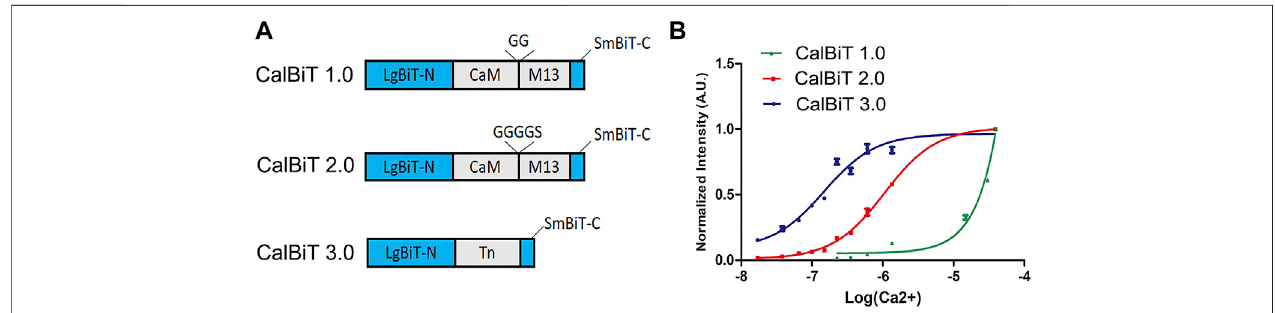
FIGURE 2 | Characteristics of CalBiTs in vitro . (A) The CaM-M13 or troponin C domain (TnC) was inserted between LgBit-N and SmBiT-C, two functional complementation fragments of NanoBiT (Dixon et al., 2016). Three versions of CalBiT were developed using different linkers and Ca ++ -binding domains. In CalBiT1.0, two Gly residues were used as linkers between CaM and M13 and GGGGS was used as a linker between CaM and M13 in CalBiT2.0, whereas TnC was the Ca ++ - binding domain inserted between LgBit-N and SmBiT-C in CalBiT3.0. (B) Comparison of [Ca ++ ] dependency in vitro for CalBiT1.0 (green line), CalBiT2.0 (red line), and CalBiT3.0 (blue line). The intensities of the three CalBiTs were measured by a QuantaMaster spectro fl uorimeter (not using fl uorescence excitation). The plotted values were normalized to the maximal signal intensity achieved at 39 mM Ca ++ . Values for the Hill coef fi cient and Kd of Cal fl ux VTN are shown in Table 2 , mean ± standard deviations. n (cid:2)